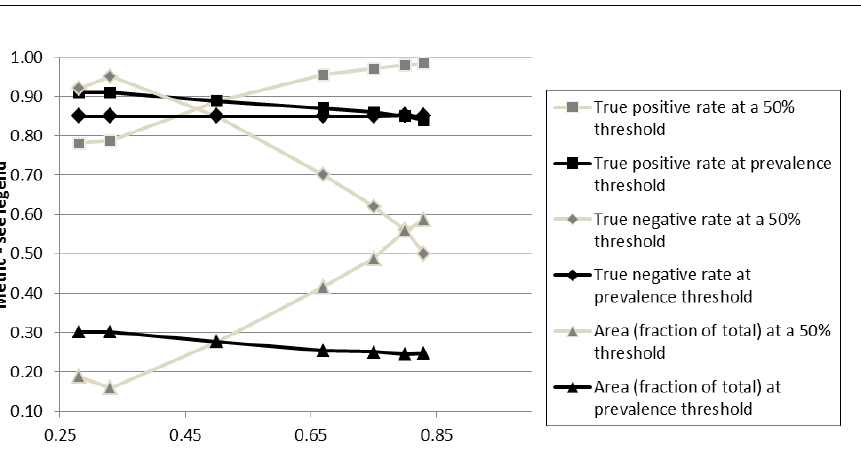
Figure 2. True positive rate, true negative rate, and area (fraction of total area) at 0.50 thresholds and prevalence thresholds. The prevalence threshold maintained true positive rate, true negative rate, and area at a relatively constant value among modeling prevalence ratios. Sampling prevalence (points located at the 0.28 x-axis, the mean sampling prevalence) did not a ff ect